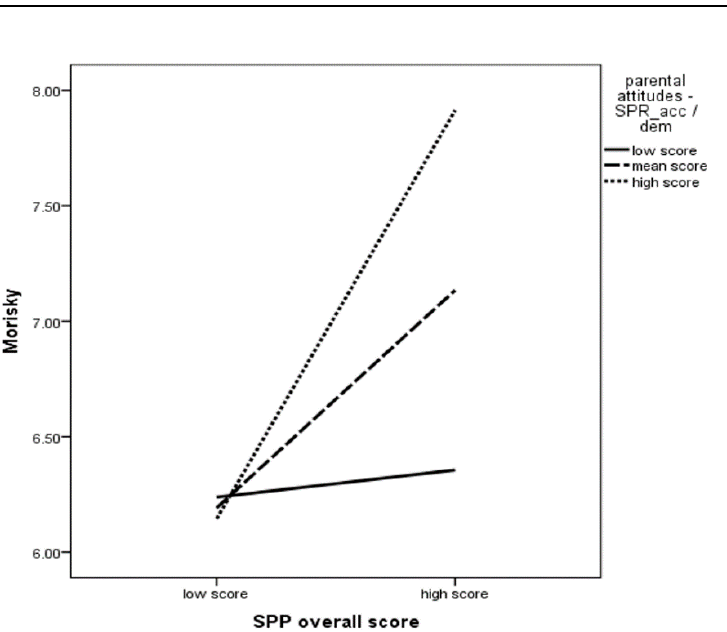
Figure 1. SPP and parental attitudes interaction effect on medical adherence (Morisky overall score).